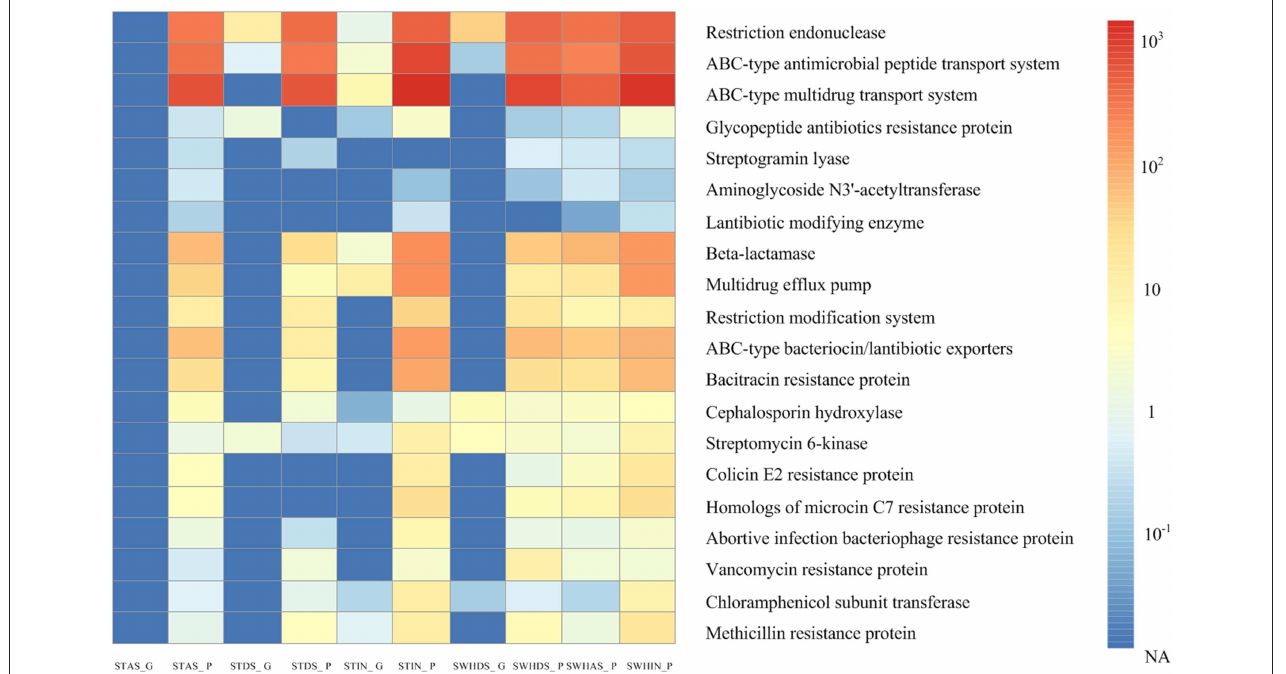
FIGURE 4 | Comparison of the plasmid metagenome to the total DNA metagenome based on the abundance of the defense mechanisms obtained using the COG database of MG-RAST. Every lattice represents the abundance of the reads.